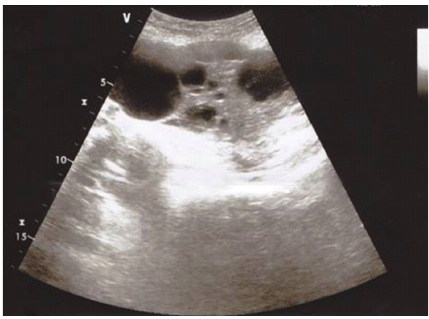
Figure 1: Endovaginal pelvic ultrasound: axial view: Adnexal mass measuring 20 cm, which is heterogeneous, with tissular and cystic components and without intracystic or extracystic exophytic vegetations and without peritoneal fluid.